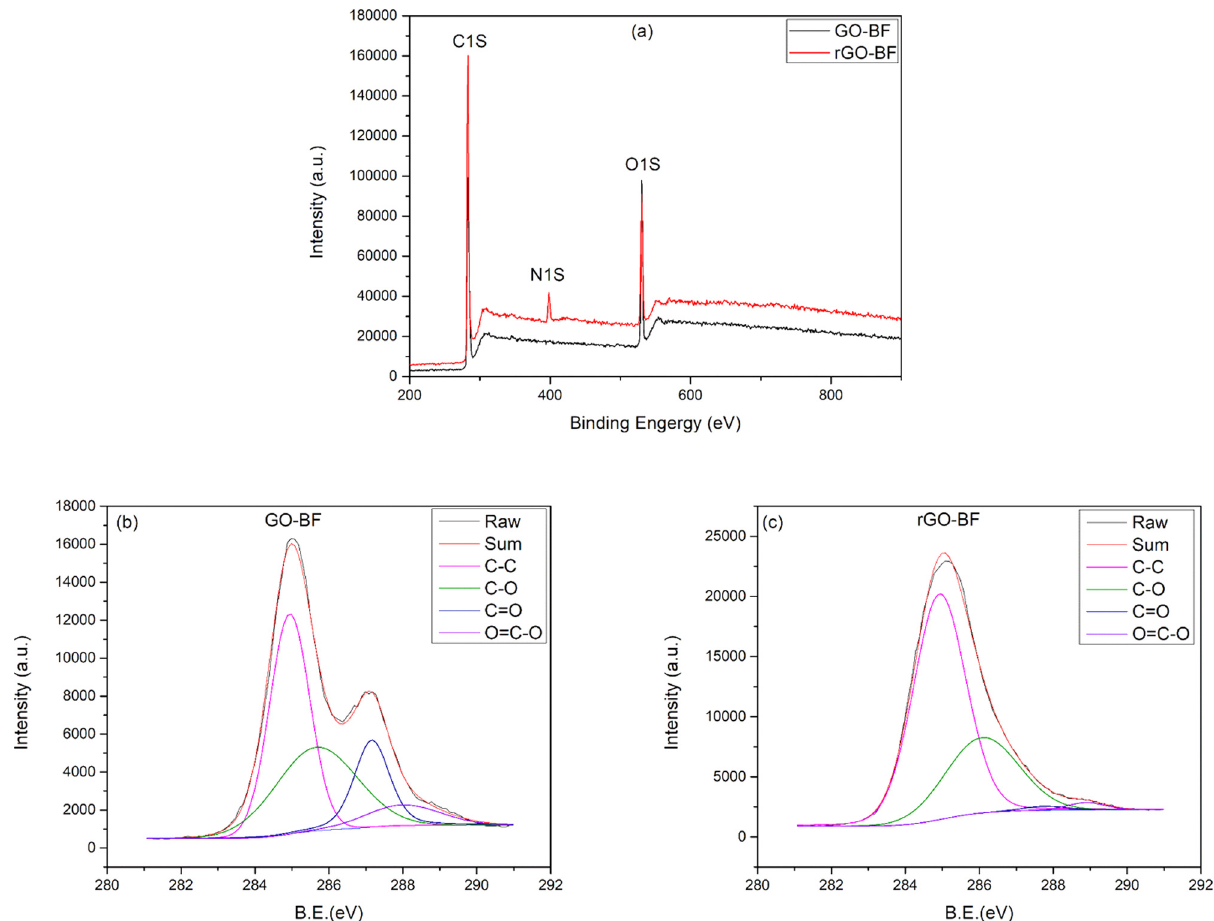
Figure 4: ( a ) XPS survey spectra of GO - coated BF ( GO - BF ) and reduced GO - coated BF ( rGO - BF ) ; ( b ) and ( c ) represent the C 1s spectra of GO - BF and rGO - BF,